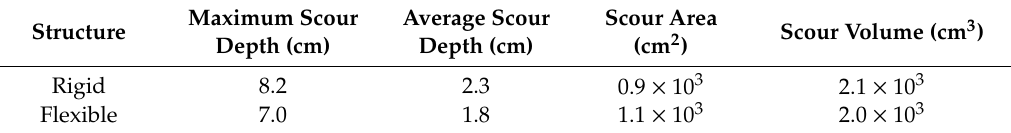
Figure 5. Bed topography near rigid and flexible flow deflectors (top view): ( a ) Rigid flow deflector, ( b ) Flexible flow deflector. Table 1. Detailed information of the scour near the flow deflectors.